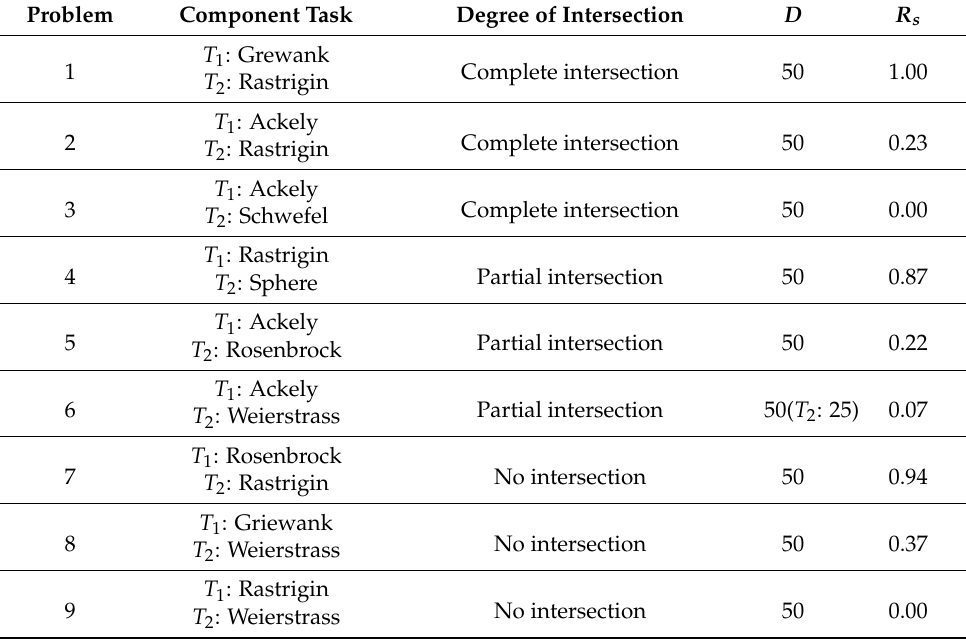
Table 1. Description of the nine MTO test problems in test suite 1.